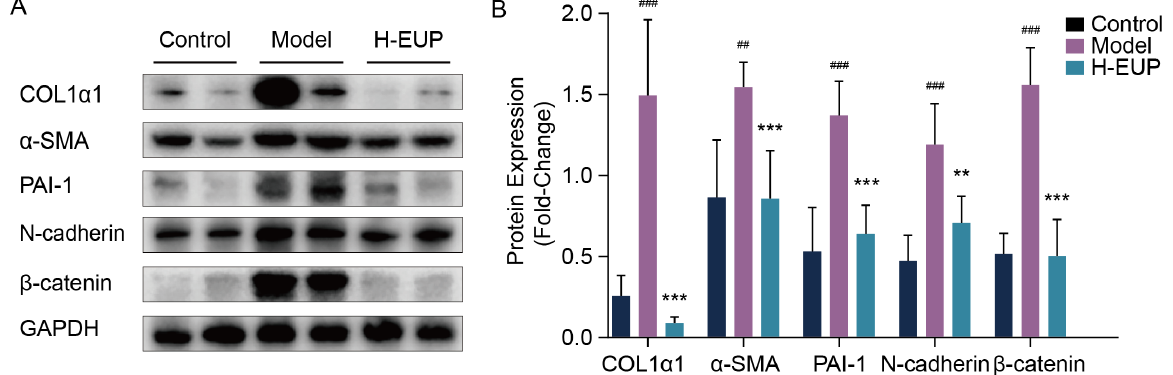
Figure 7. Eupatilin inhibits expression of COL1 α 1, α -SMA, PAI-1, N-cadherin, and β -catenin in the liver tissues of model group treated with the high-dose eupatilin. ( A ) Western blot analysis of COL1 α 1, α -SMA, PAI-1, N-cadherin and β -catenin in CCl4-induced mice liver tissues treated with eupatilin (40 mg/kg). ( B ) Relative protein signal intensity was quantified as mean ± standard deviation (mean ± SD, n = 6). ## p < 0.01 and ### p < 0.001 vs. control group. ** p < 0.01